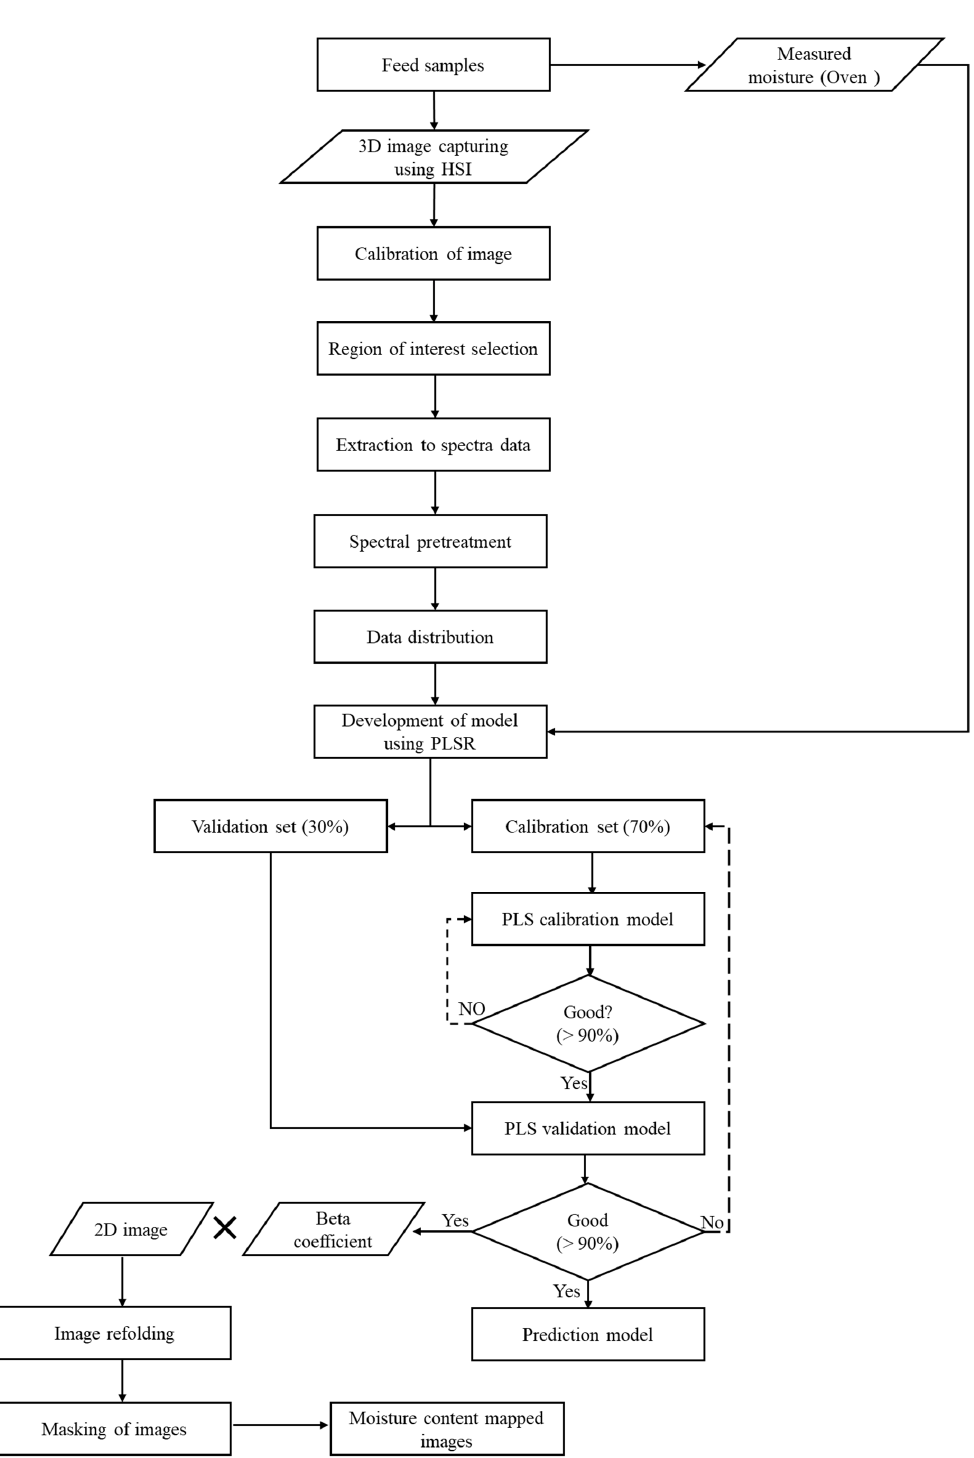
Figure 4. Steps used in processing hyperspectral images and developing moisture content prediction models regardless of the type of feed and feed materials.